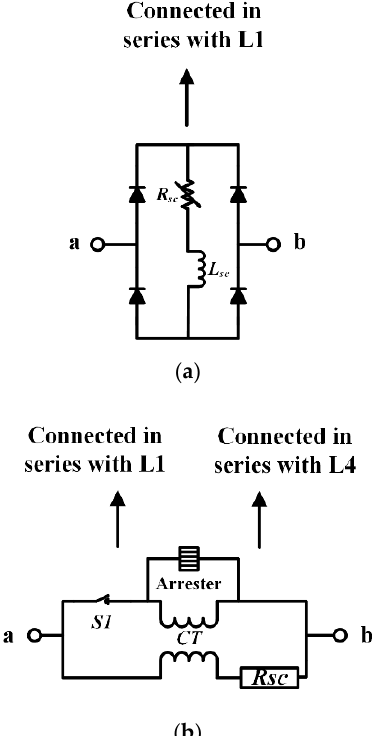
Figure 10. ( a ) The DC-resistive superconducting fault current limiter [36]; and ( b ) the resistive-flux-coupling type superconducting fault current limiter (SFCL) [38].